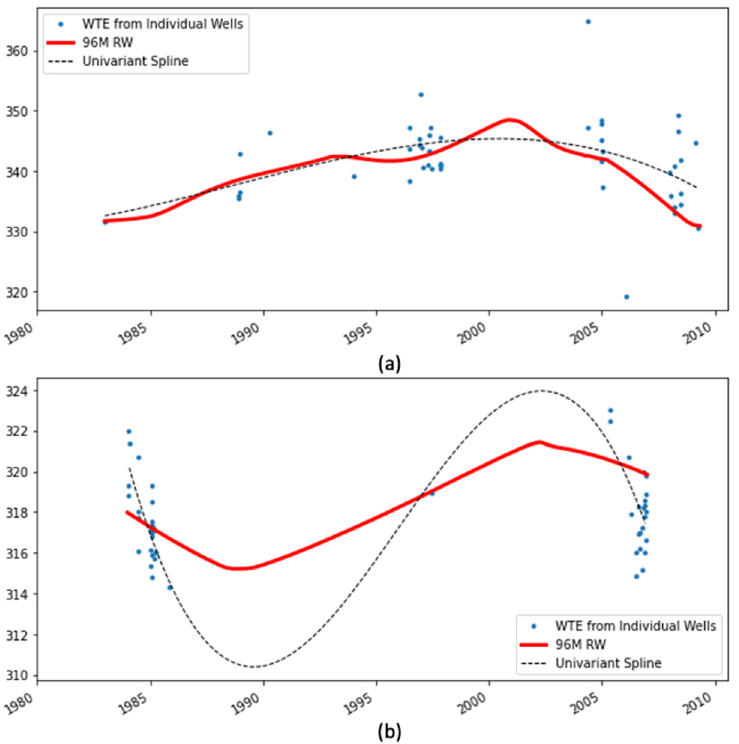
Figure 11. The synthetic WTE time series at the pseudo-well ( a ) when the univariate spline interpo- lation was selected and ( b ) when the moving-average interpolation was selected.